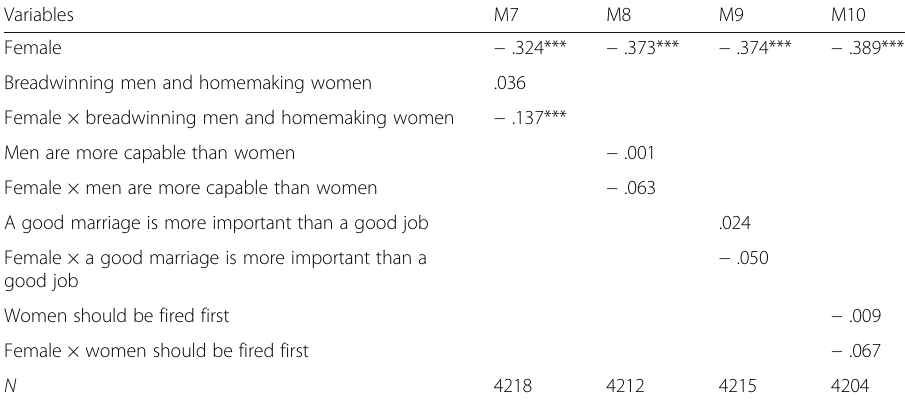
Table 4 Impact of specific gender role attitudes on labor income